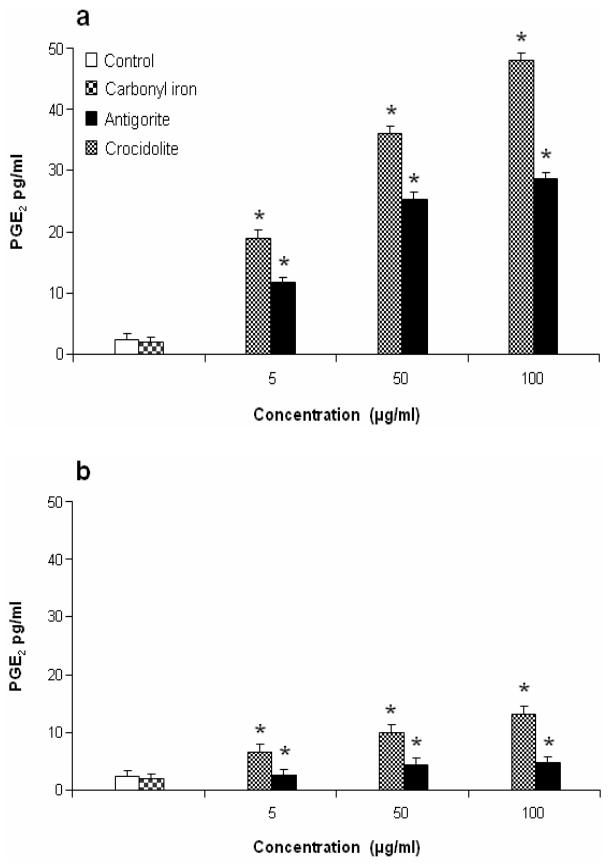
Figure 9: Determination of PGE formation by ELISA in 2 the MeT-5A (a) and J774 (b) cell culture media. The values, expressed as pg/ml, are the mean ± SEM of three experiments performed in triplicate. * - denotes significant differences at